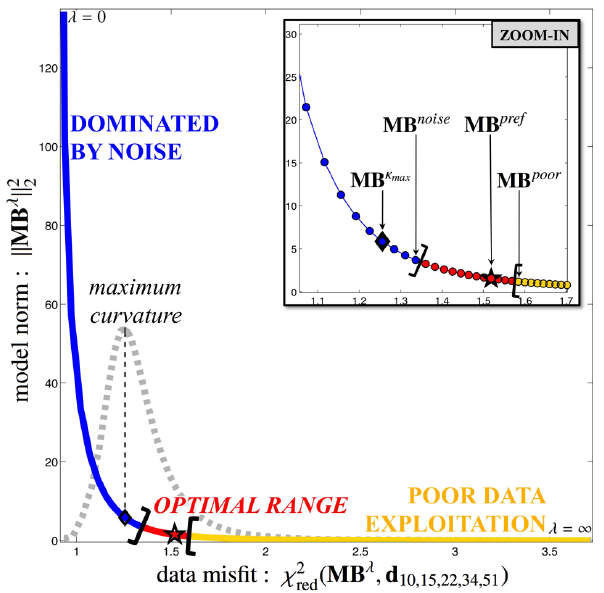
Fig. 1. Summary of our approach for objectifying the choice of Fig. 2. Plot of the curve of trade-off between the model ‘ ∞ -norm, || MB λ || ∞ , and its residual data misfit, χ 2 ( MB λ , d 10 , 15 , 22 , 34 , 51 ) . regularisation parameter (damping). We plot the curve of trade- red off ( L curve) between the model norm, || MB λ || 2 , and its residual A sharp change of behaviour of the model ‘ ∞ -norm occurs as the 2 damping λ gets lower than a threshold value λ poor , which is inter- ( MB λ , d 10 , 15 , 22 , 34 , 51 ) , as damping λ varies. The data misfit, χ 2 red preted as the signature of data noise starting to significantly pollute L curve is displayed with solid-line parts in blue, red and light or- at least one model component. Models with damping λ ≥ λ poor are ange, corresponding to different model ranges. Its curvature κ is identified as with “poor data shown with a grey dashed line (with arbitrary amplitude scaling). The model MB κ max (black diamond) corresponds to the maximum curvature of the L curve. The two extreme models MB noise and MB poor delimit the range of models “dominated by noise” or “with poor data exploitation”, respectively. In Sect. 3.3, we show that the selection of our preferred model MB pref (black star), from the re- maining “optimal range” of permitted models, can be qualified as quasi-objective.